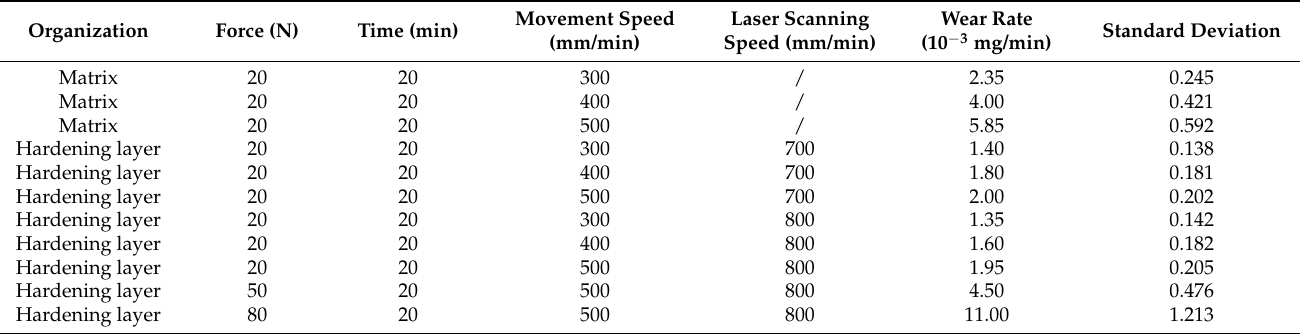
Table 4. Friction states under various wear